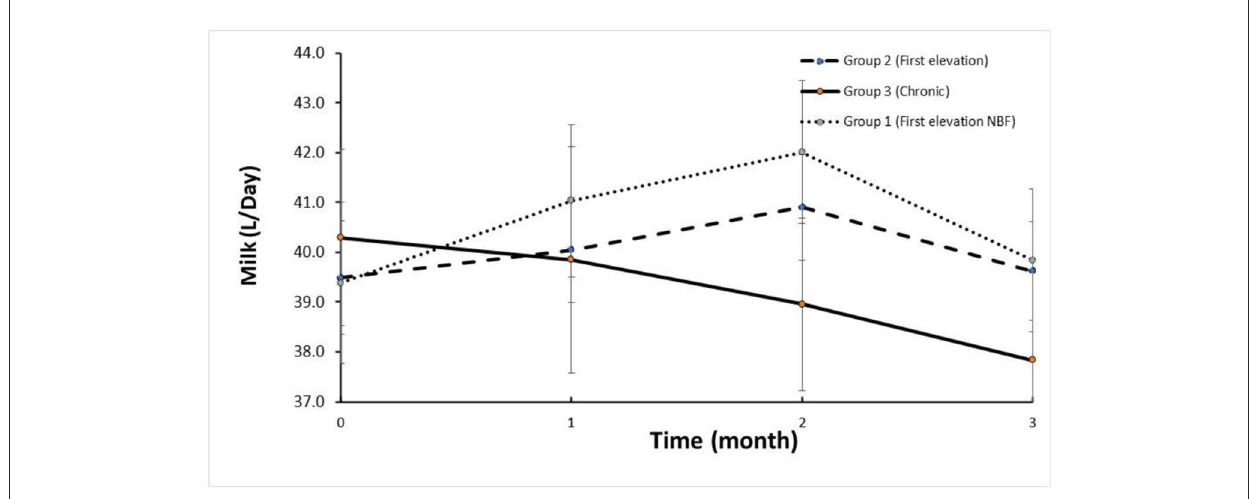
FIGURE2 Average daily milk yield (L/day) relative to APT treatment according to